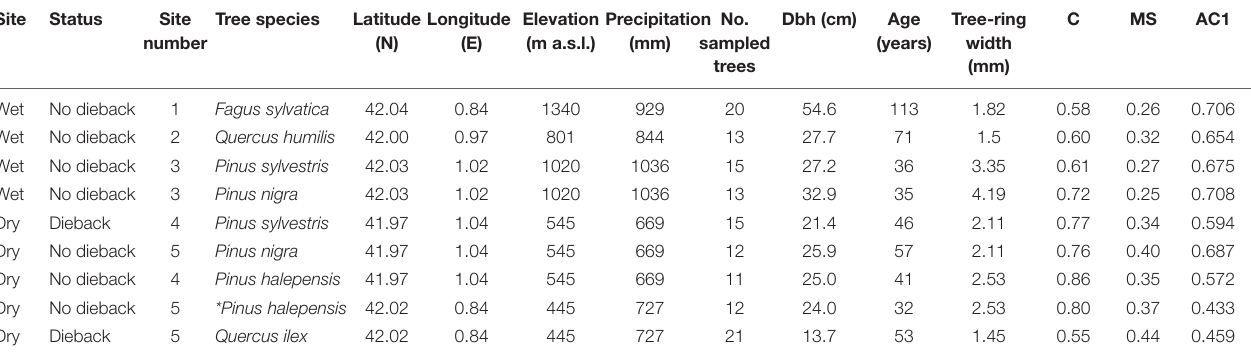
TABLE 1 | Main characteristics of the sampled sites and species.